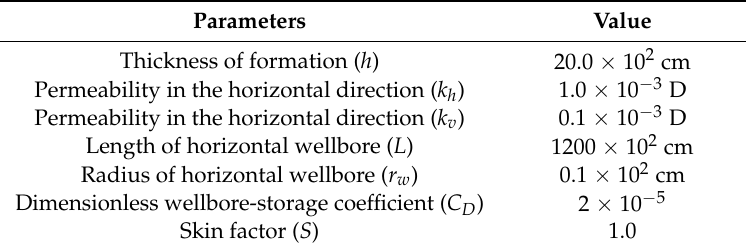
Table 1. The basic parameters of reservoir and MFHWs (constant for Figures